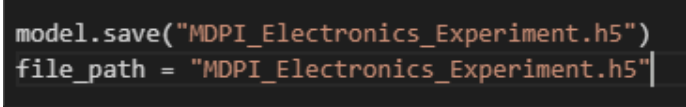
Figure 7. Selection of optimizer and loss function for output accuracy tuning. Figure 8. Commands for saving trained model and weight